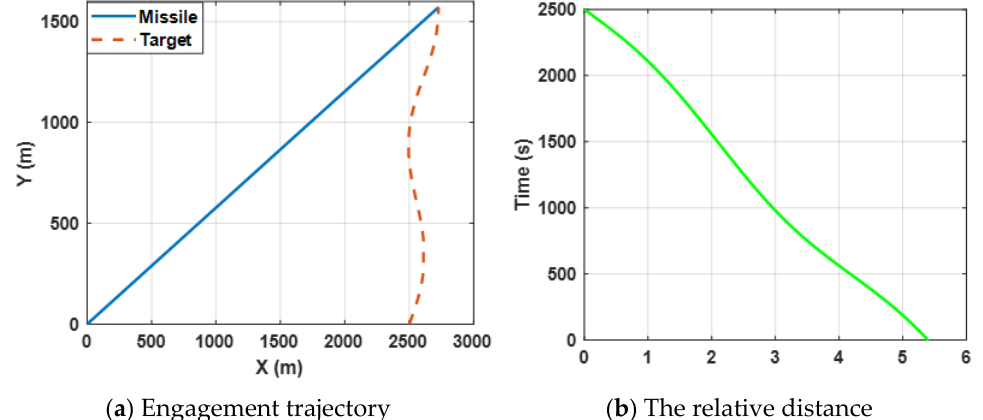
Figure 6. Engagement scenario for maneuvering target.